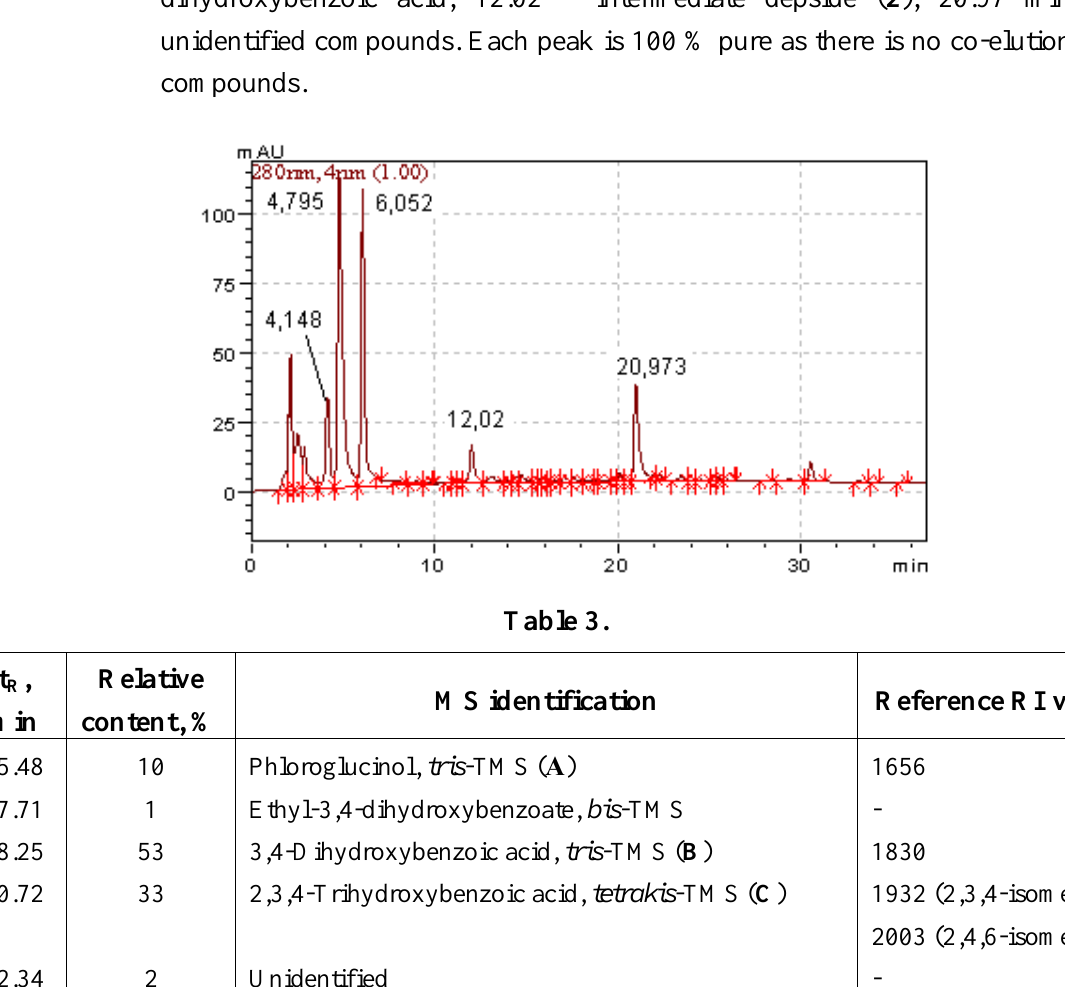
4.15 min – phloro- R